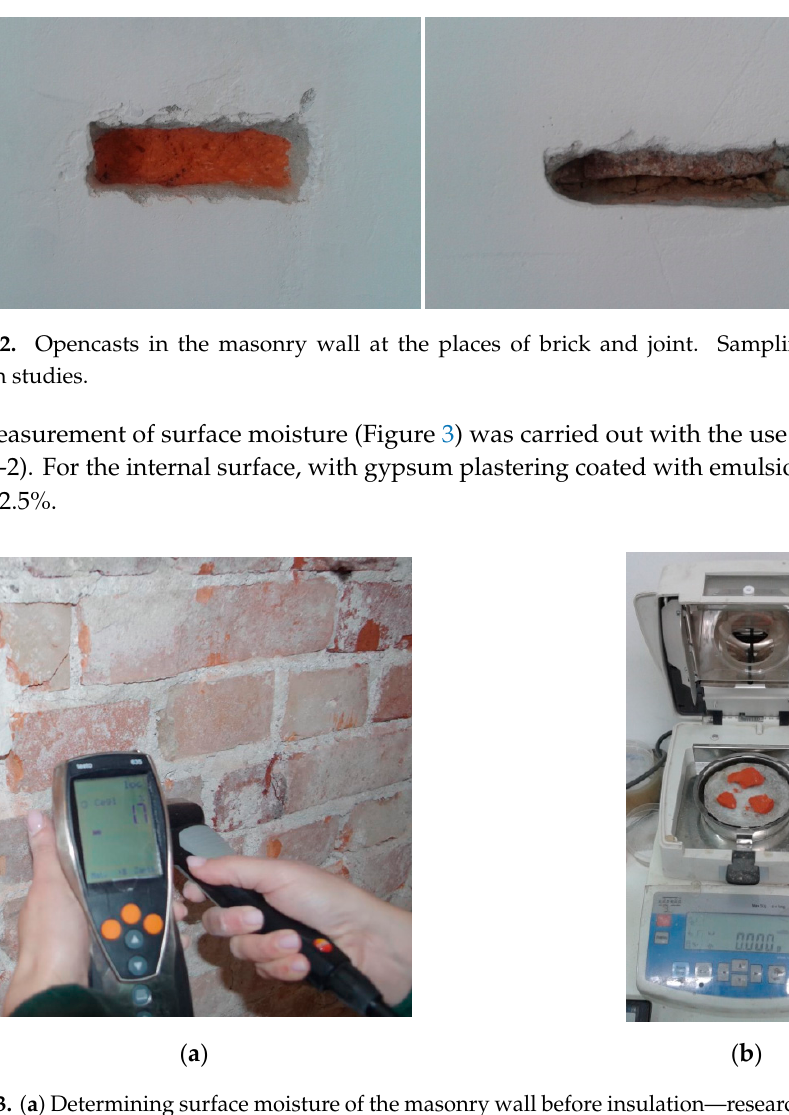
Figure 3. ( a ) Determining surface moisture of the masonry wall before insulation—research was carried out to determine the so ‐ called moisture maps areas with different moisture; ( b ) measuring water content of brick samples (taken on the basis of developed moisture maps for the wall; thanks to the water content measurement, the actual water content for the wall was assumed in the numerical analysis).